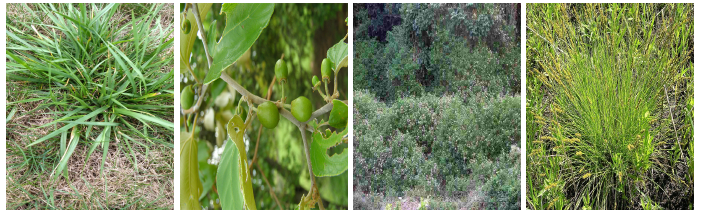
Figure 7. From left to right: Fescue grass, Chinee apple, Lantana camara , Sedge weed (Source: